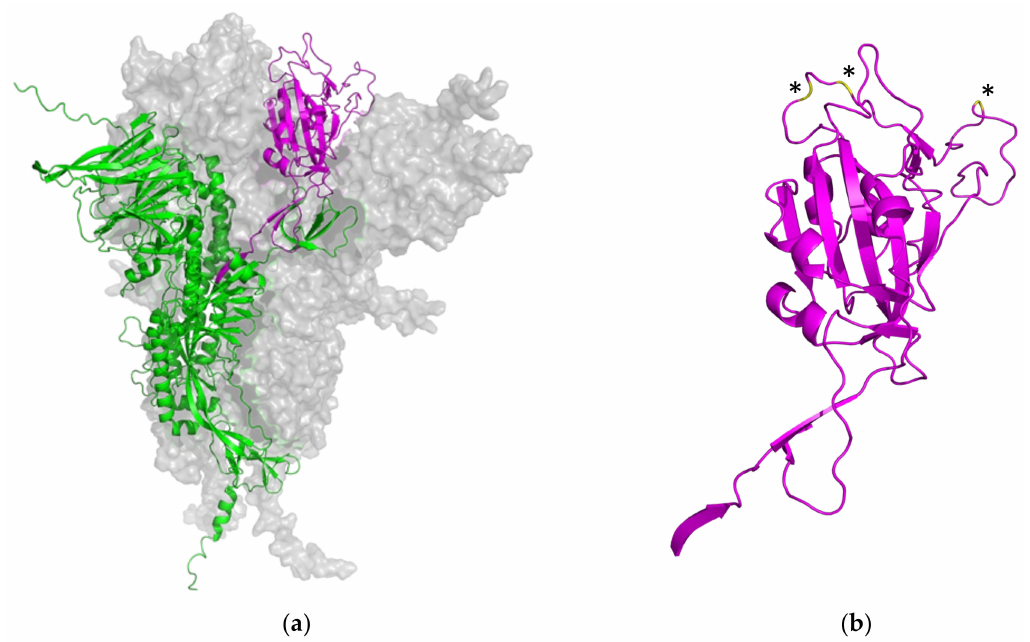
Figure 6. ( a ) Overall representation of the homotrimeric Spike structure of SARS-CoV-2 (two ho- momers are shown as light gray surfaces). One monomeric structure is shown in more detail as a ribbon representation. The ACE2 receptor binding domain is shown in magenta, and the N-terminal domain, the general structure, the central helix, and the connector domain are shown in green. ( b ) Ribbon representation of wild type S-RBD domain 314–541 used for the S-RBD PETIA (magenta). Omicron B.1.1.529 mutations (E484A, Q498R, N501Y) within the S-RBD are highlighted in yellow and indicated by asterisks. Predictions by AlphaFold 2.2.4, based on the UniProt P0DTC2 SARS-CoV-2 protein